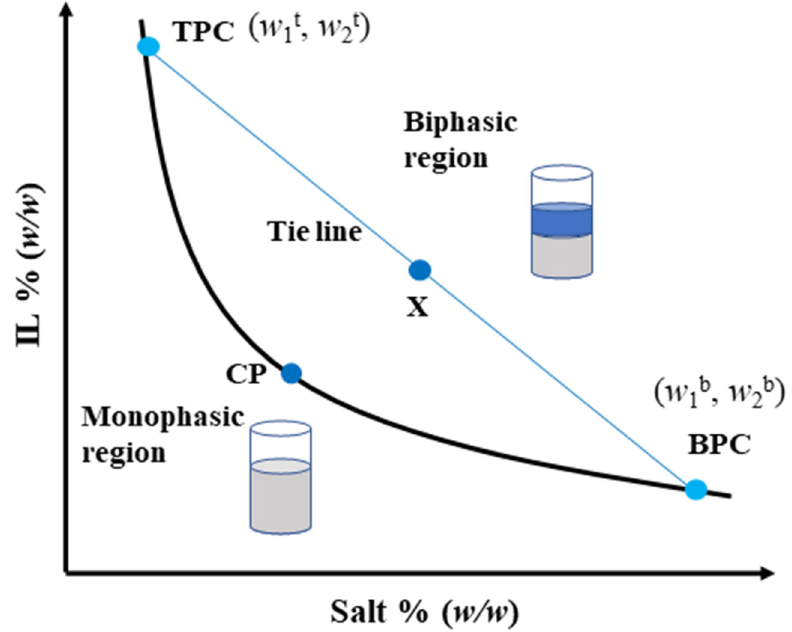
Figure 3. Conceptual diagram of an ATPS constituted of IL and salt, where the ordinate axis represents the IL concentration in % (w/w) and the abscissa axis the salt concentration in % (w/w).